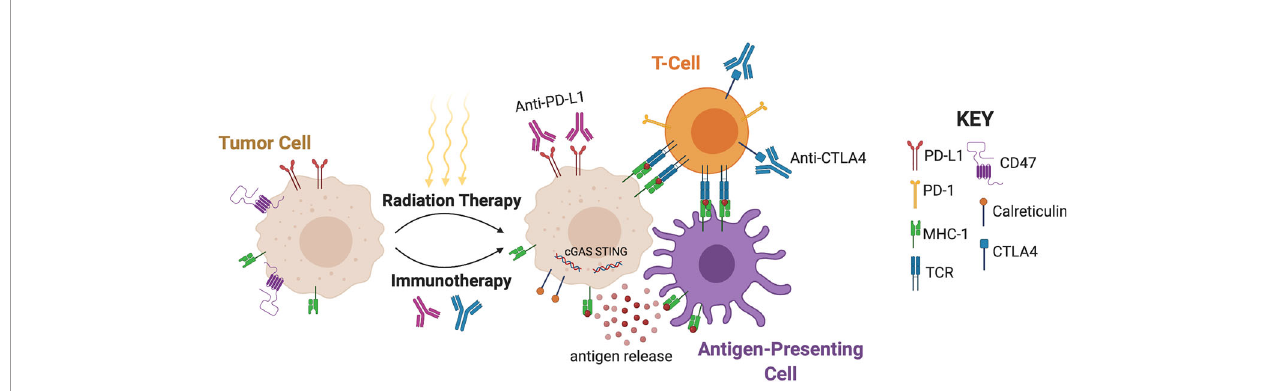
FIGURE 1 | Mechanisms underlying synergy of radiotherapy and immunotherapy. Radiation promotes the ability of antigen-presenting cells to present tumor antigens to naive T cells through antigen release, stimulation of calreticulin, and downregulation of CD47. MHC-1 expression and the subsequent antigen presentation leads to interaction with T-Cell Receptors (TCR). Moderate doses of radiation also activate a type I interferon response through the sensing of cytoplasmic DNA via cGAS-STING. Radiation can upregulate PD-L1 and CTLA-4, and therefore immunotherapy can augment radiation ef fi cacy by targeting these pathways. (Created with